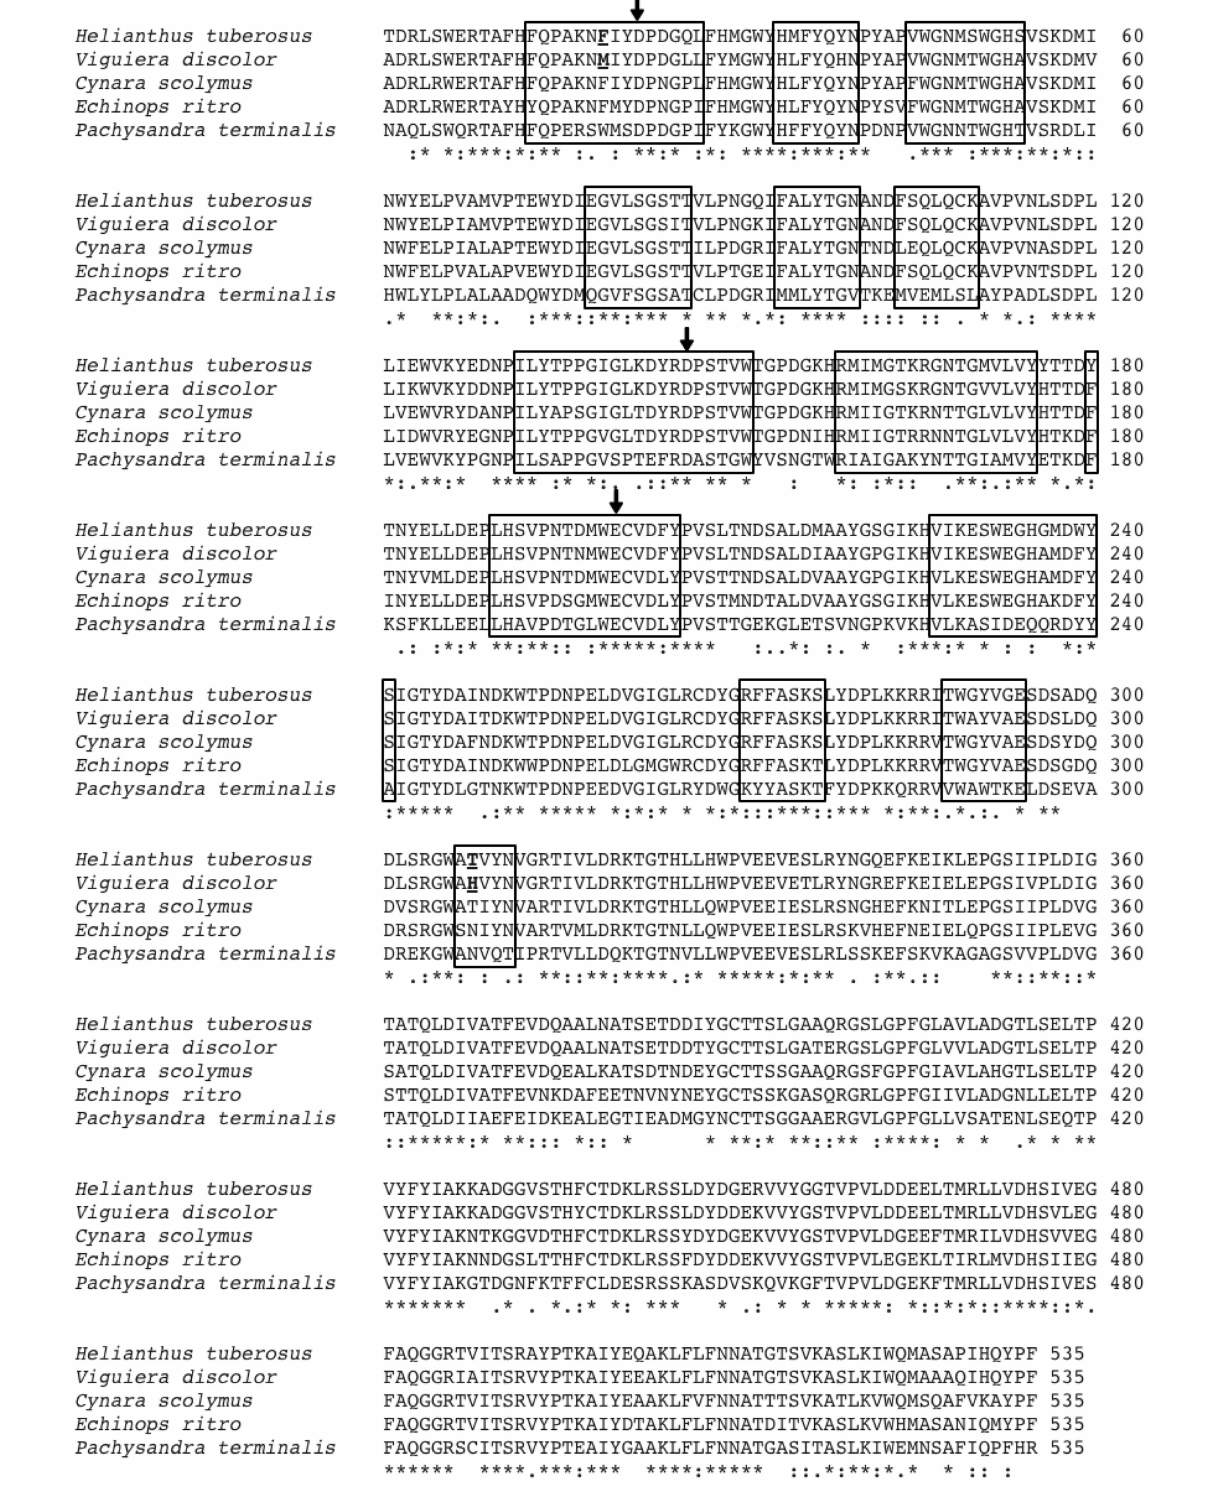
are based. The regions situated at a distance of 12Å or less from the catalytic triad (amino acids indicated with arrows) are indicated with a box. The amino acids, chosen for mutation, at positions 19 and 308 are